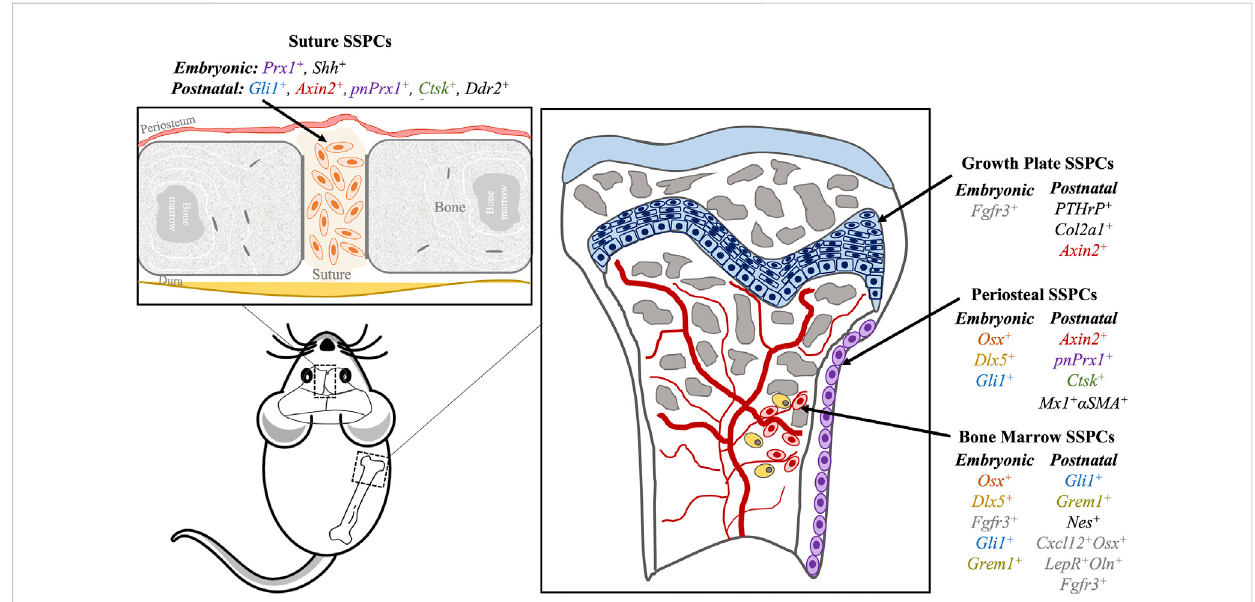
FIGURE 1 Skeletal stem progenitor cells (SPPCs) in different bone compartments in mice. Several markers of SSPCs per location (suture, growth plate, periosteum, bone marrow) are summarized here. Similar markers have similar text colors (i.e., Axin2, Ctsk, pnPrx1 and Gli1